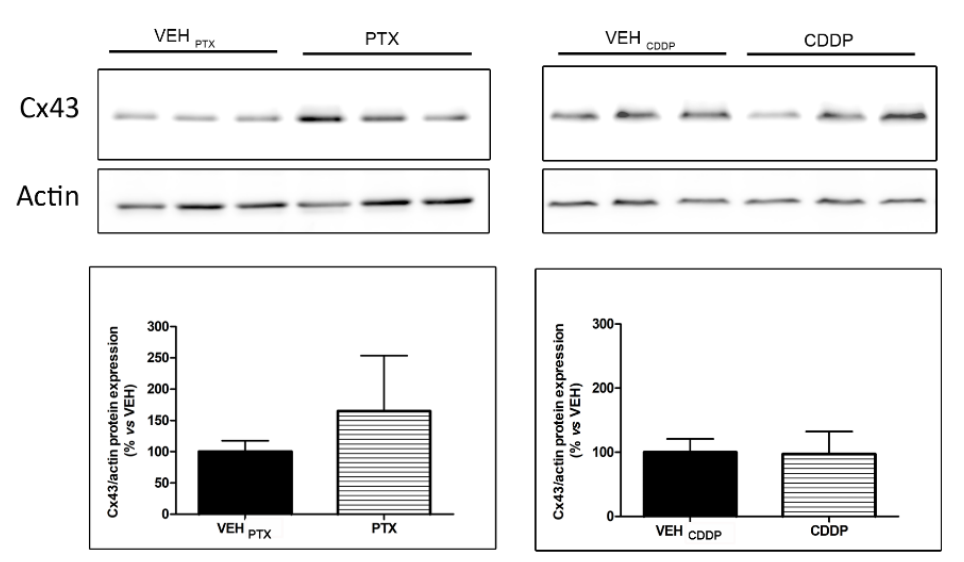
Figure 4. Western blot analysis and quantification for Cx43 in the DRG. VEH: vehicle; CDDP: cisplatin; PTX: paclitaxel.